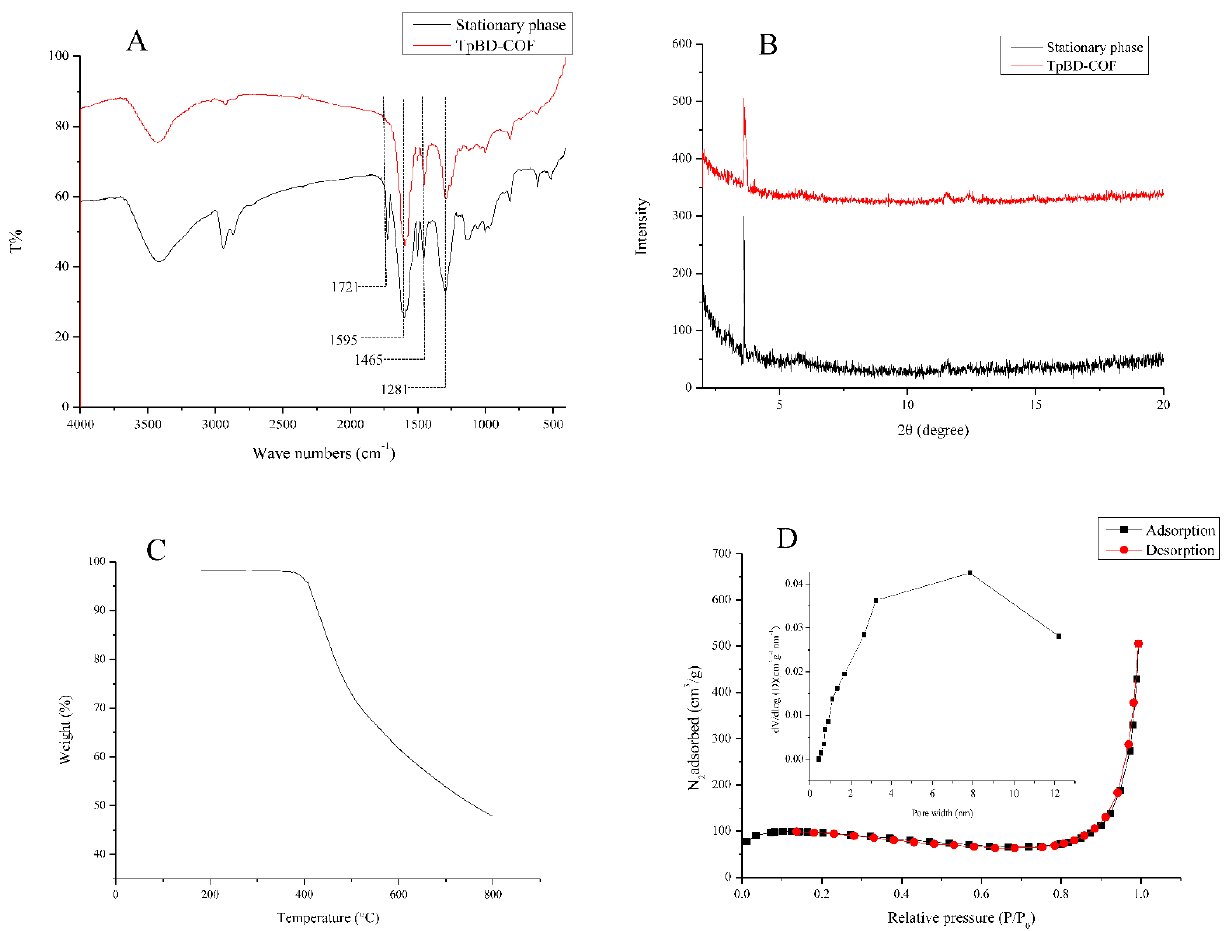
Figure 4. Characterization of the stationary phase in the TpBD COF immobilized capillary. ( A ) FTIR spectra, ( B ) X-ray diffraction, ( C ) TGA curve and ( D ) nitrogen adsorption-desorption isotherms. Insert: Pore size distribution.